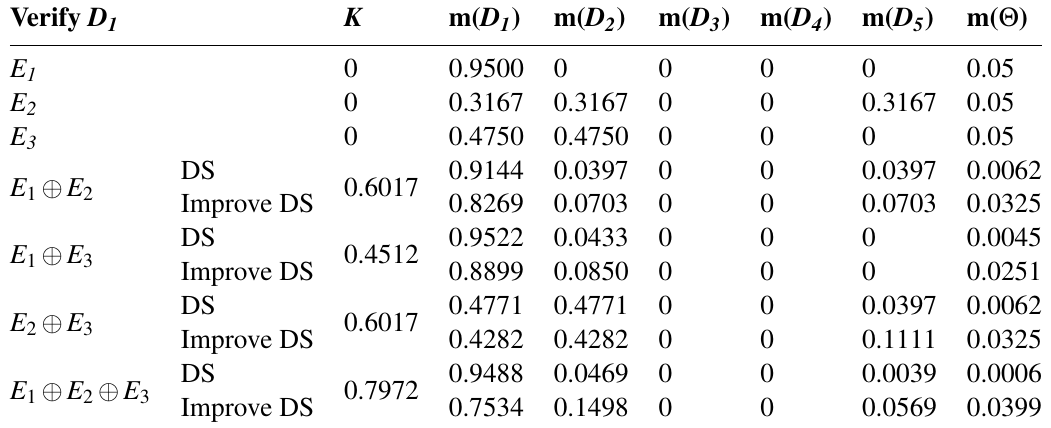
Table 4 Basic probability assignment about D 1 .